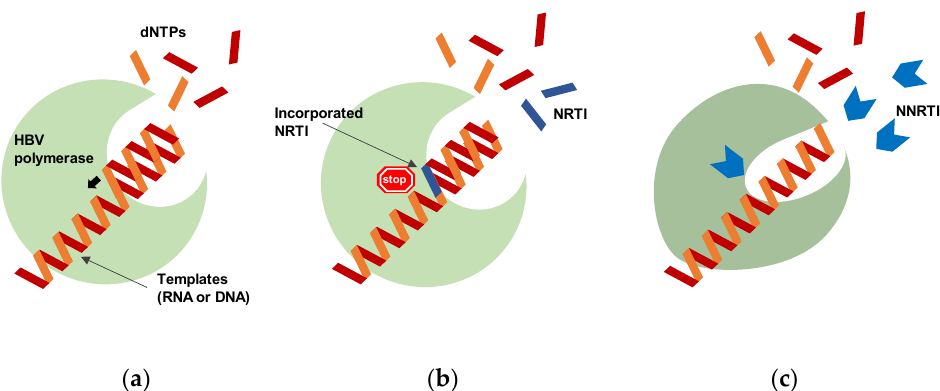
Figure 2. Different roles between nucleos(t)ide RT inhibitors (NRTIs) and non-nucleos(t)ide RT inhibitors (NNRTIs). ( a ) Deoxyribonucleotide triphosphates (dNTPs) are incorporated into nascent DNA during reverse transcription (minus-strand DNA synthesis) and plus-strand DNA synthesis. ( b ) NRTIs block DNA synthesis via chain termination by incorporating themselves into the nascent DNA. ( c ) NNRTIs block DNA synthesis via direct binding to the polymerase and causing enzyme conformational changes that disrupt active-site function, leading to impairment of polymerization